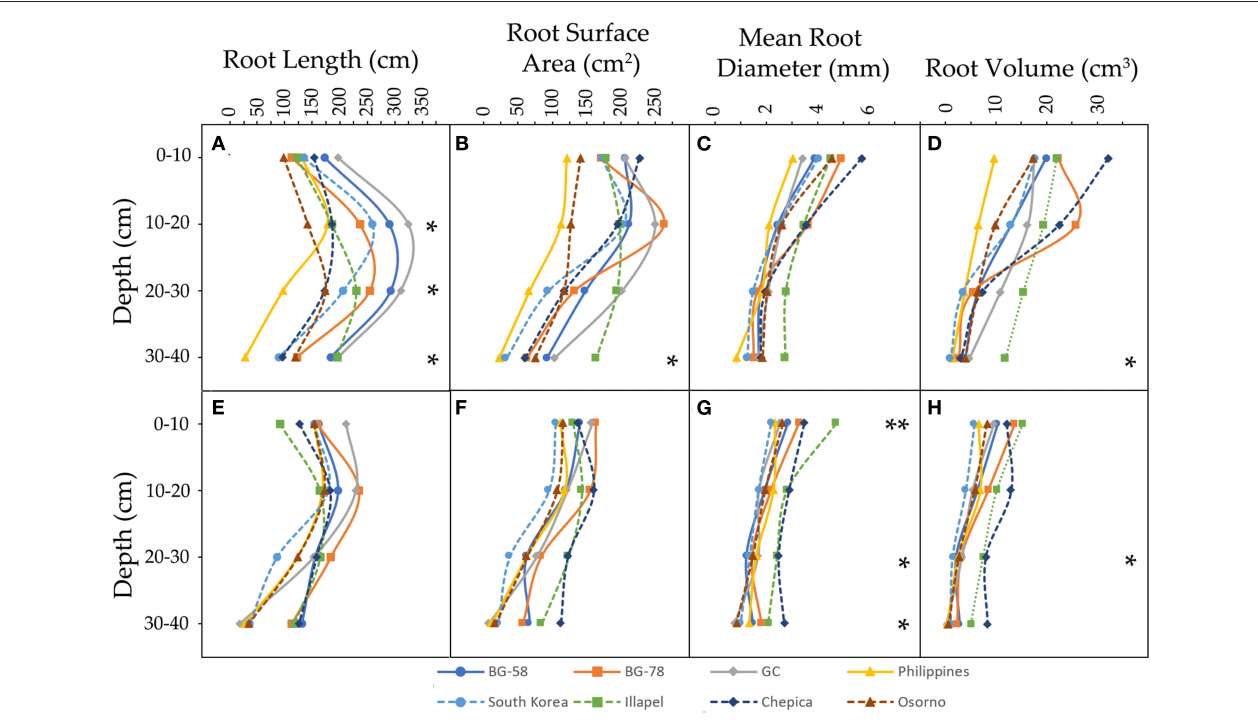
FIGURE 2 | Distribution of root traits [root length (A,E) , root surface area (B,F) , mean root diameter (C,G) , and root volume (D,H) ] in four depth layers (0–10, 10–20, 20–30, and 30–40cm) of eight bottle gourd genotypes, grown under well-watered (A–D) and water-deficit conditions (E–H) . * and ** denote the level of significance at 5 and 1%